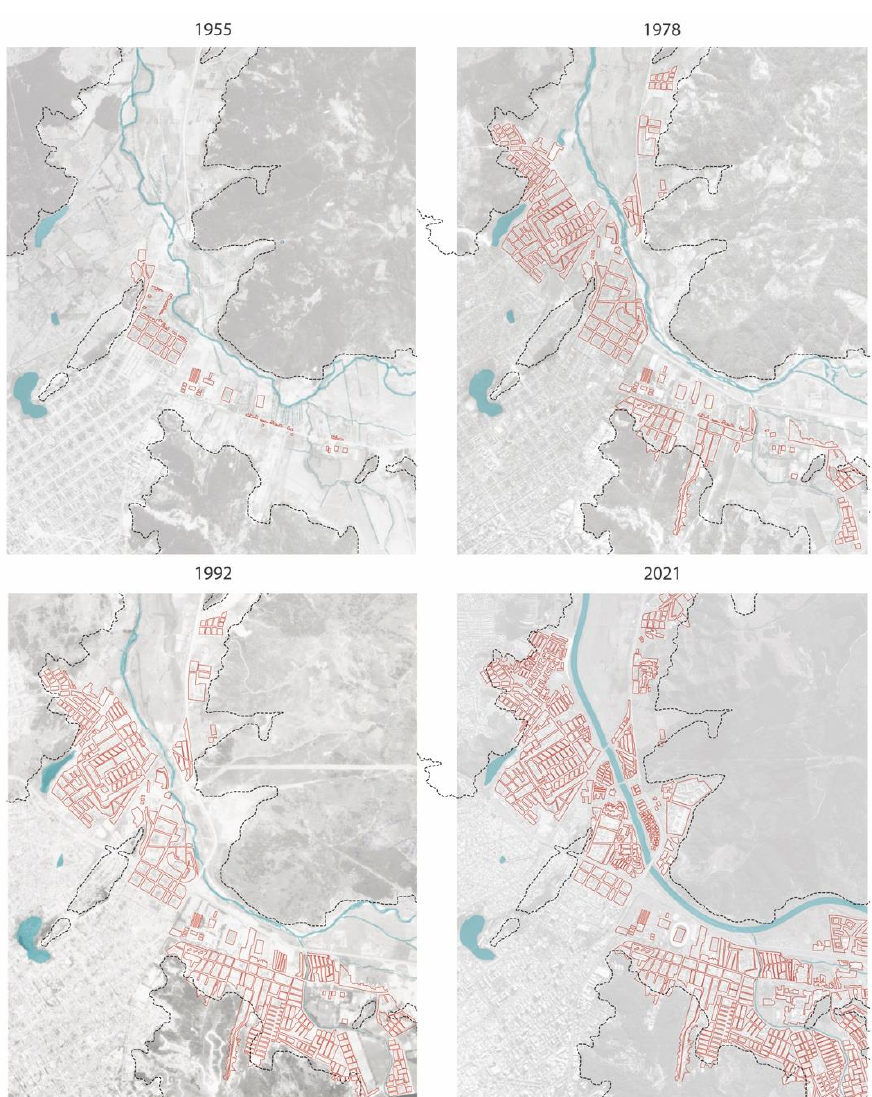
Figure 4. Comparison of the urbanization process in the Andalién floodplain. Analysis based on aerial photographs of 1955, 1978, 1992 and 2021. Red: urbanization, Blue: the river and water bodies, Black: Contour of hills. Source: by the author Espinosa.